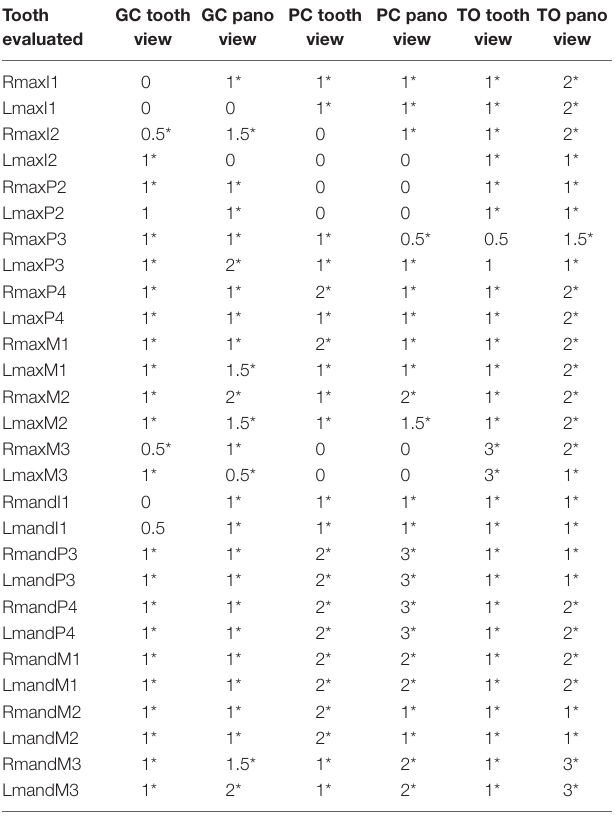
TaBle 2 | Median difference between the score values of cBcT and conventional cT on sagittal tooth view, 3D reconstructed, and panoramic images.